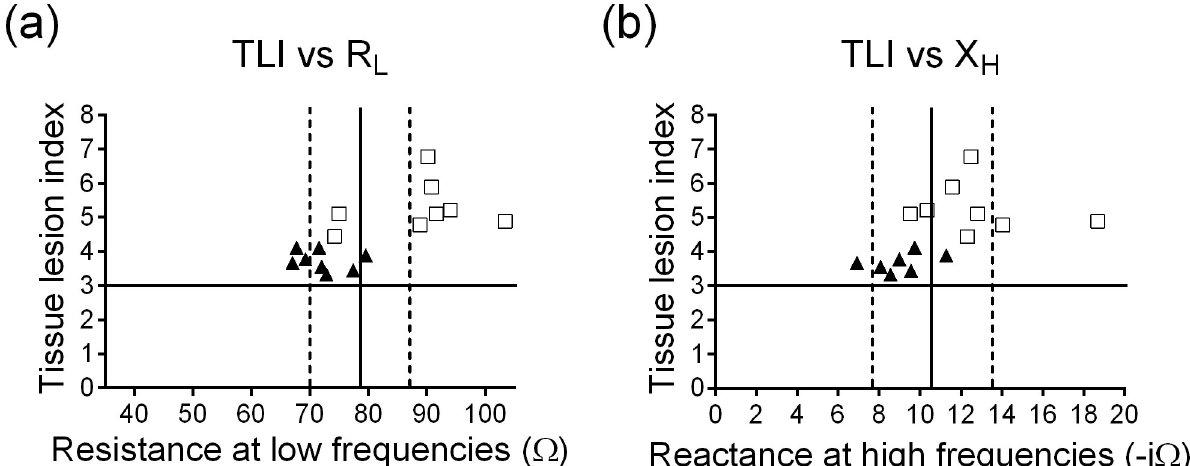
Fig 4. Comparison of the TLI score vs the impedance parameters (R L and X H ). Identifiers: ( □ ) I/R group, ( ▲ ) I/R+MT group.